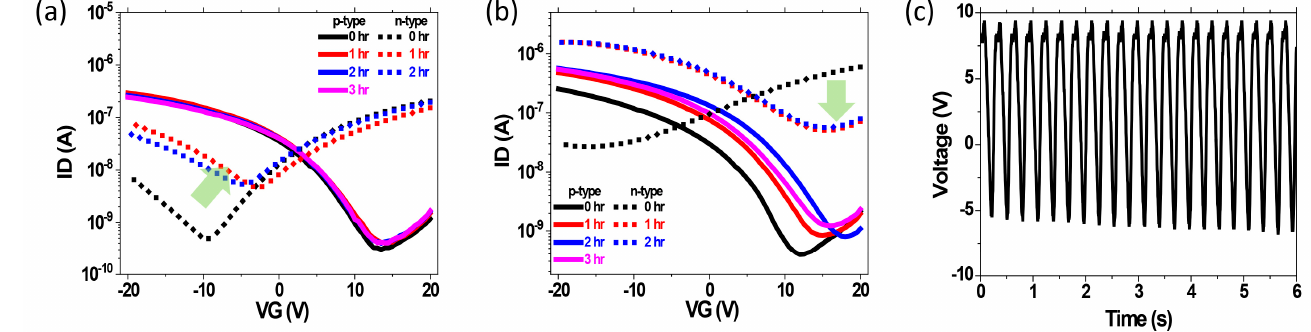
Figure 4. The Temperature Humidity Test (85% humidity at 85 °C) for the printed 1 ‐ bit code gener ‐ ator. Transfer characteristics of pSWCNT ‐ TFTs at 85% of identity at 85 °C ( a ) with SiNx passivation layer and ( b ) with CYTOP passivation layer along with time. ( c ) The output characteristics of SiNx (~200 nm) ‐ passivated 1 ‐ bit code generator after keeping under 85/85 test condition for 24 h.